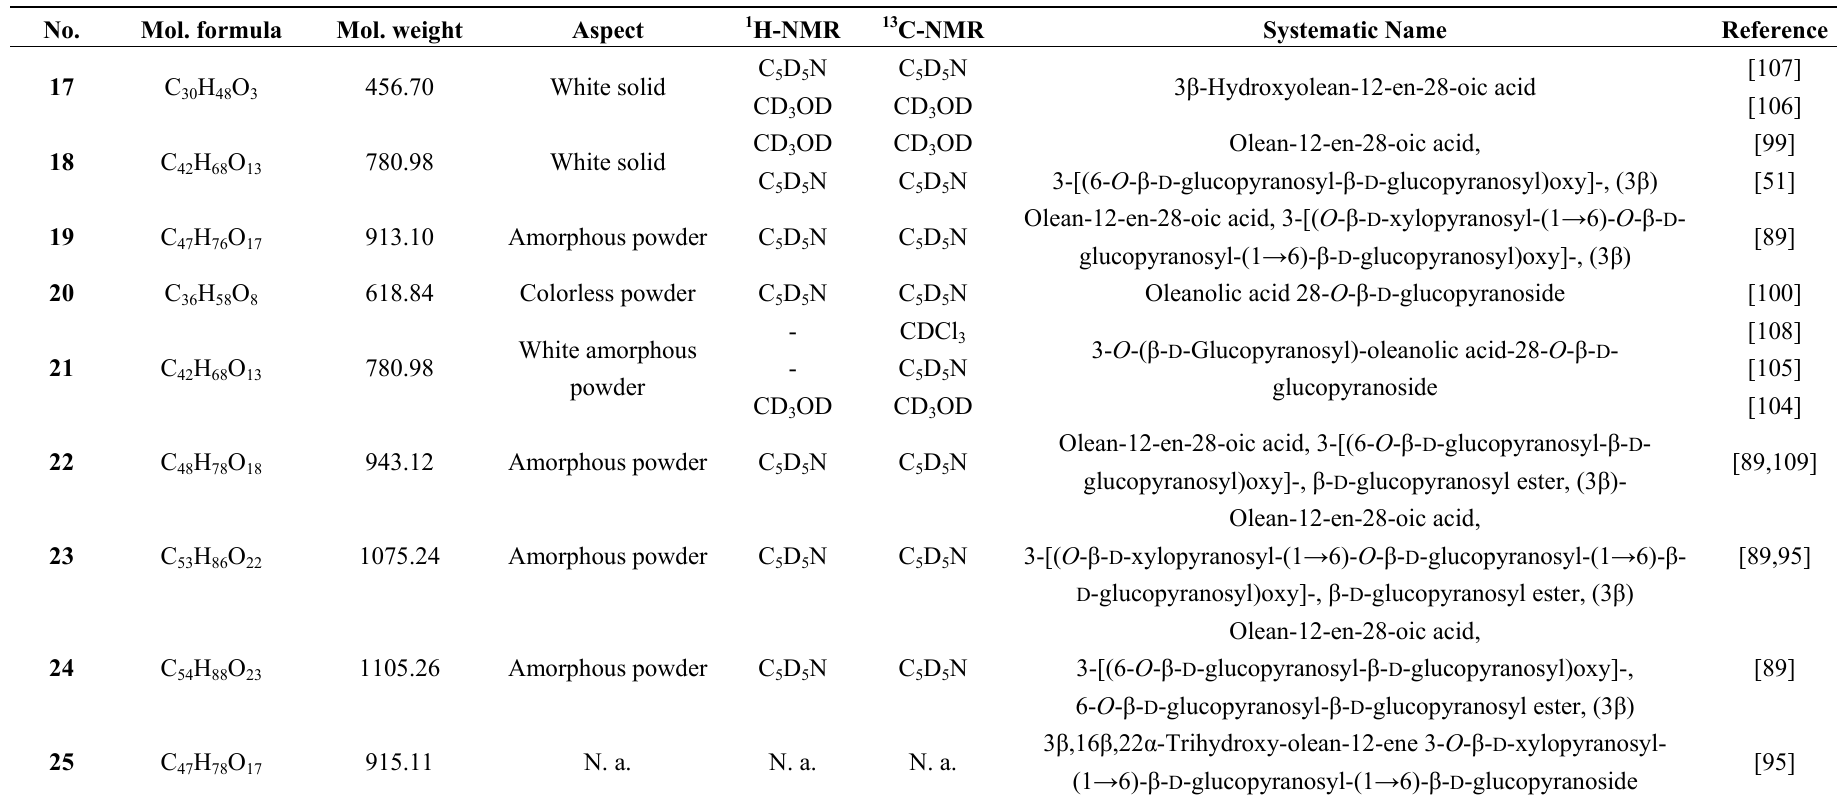
Table 7. Systematic names and chemical and spectral data of compounds 17 – 25